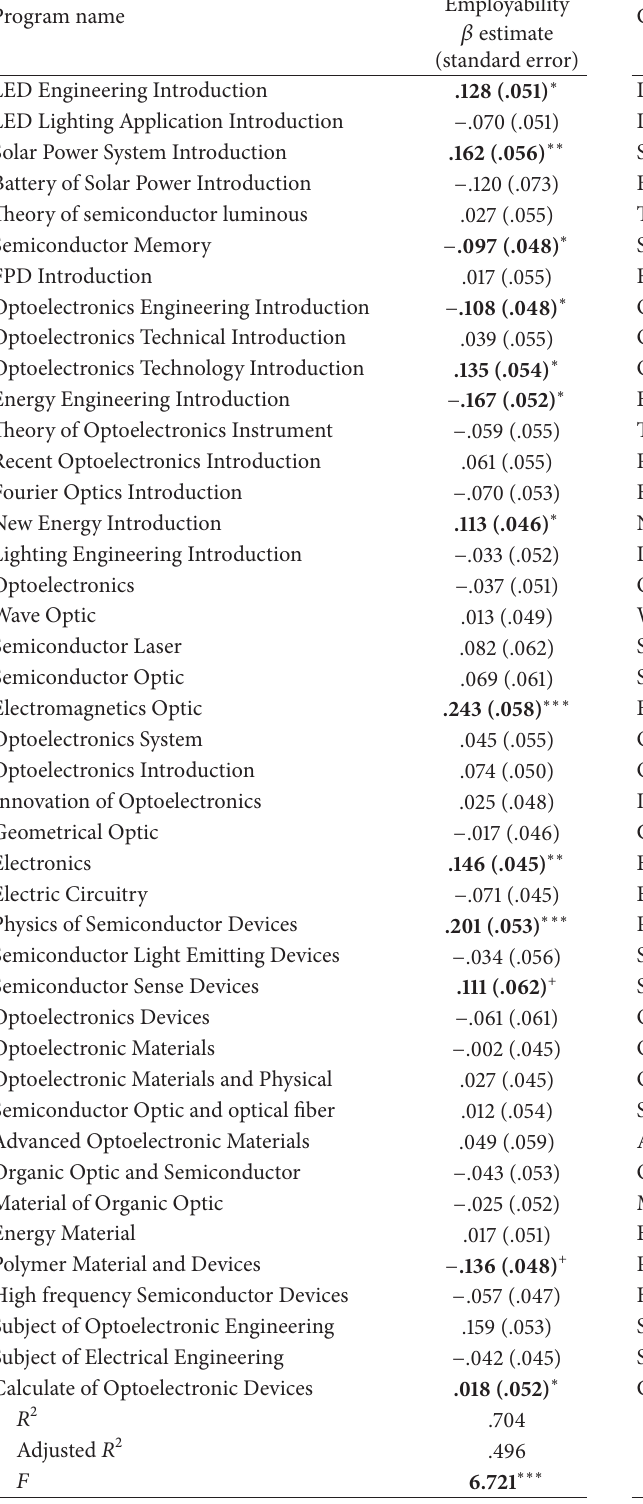
Table 10: Multiple regression analysis—cognitive domain curricu- lum on employability (university sample).